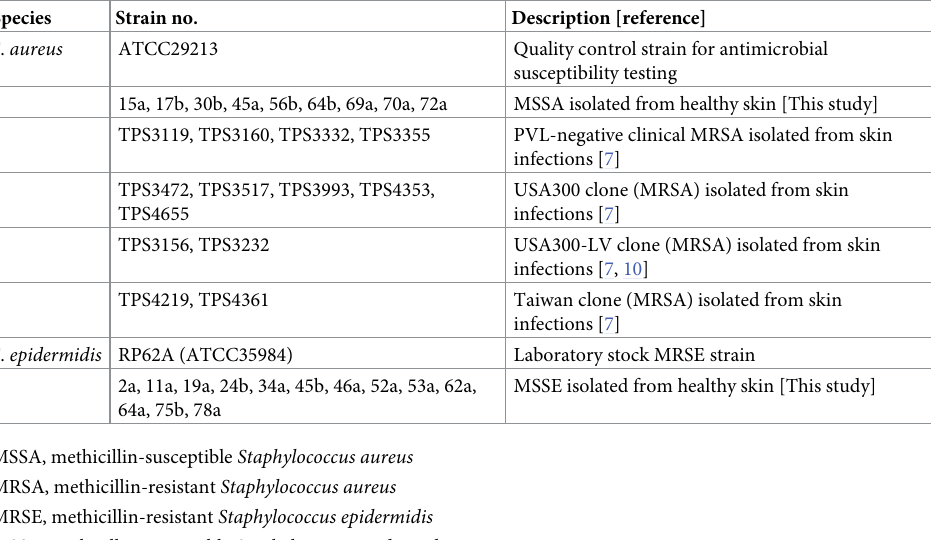
Table 1. Bacterial strains used in this study. Species Strain